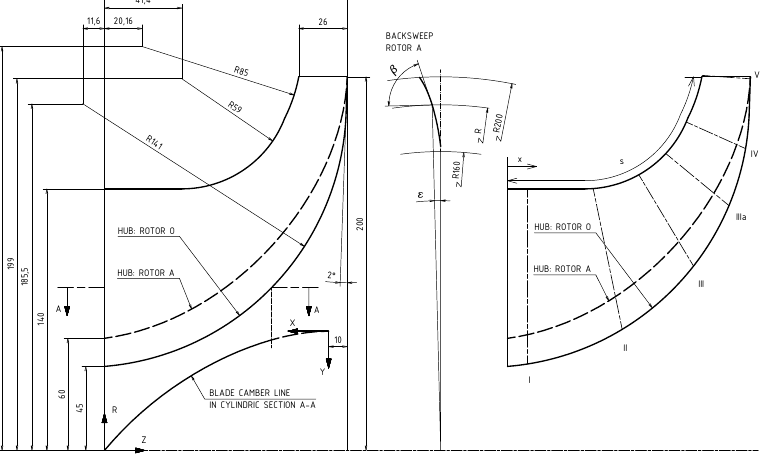
Figure 4. A detailed sketch of Eckardt’s compressors (both type A and O) with their corresponding dimensions: ( left ) Main dimensions of the impeller; ( right ) position of individual cross-sections.